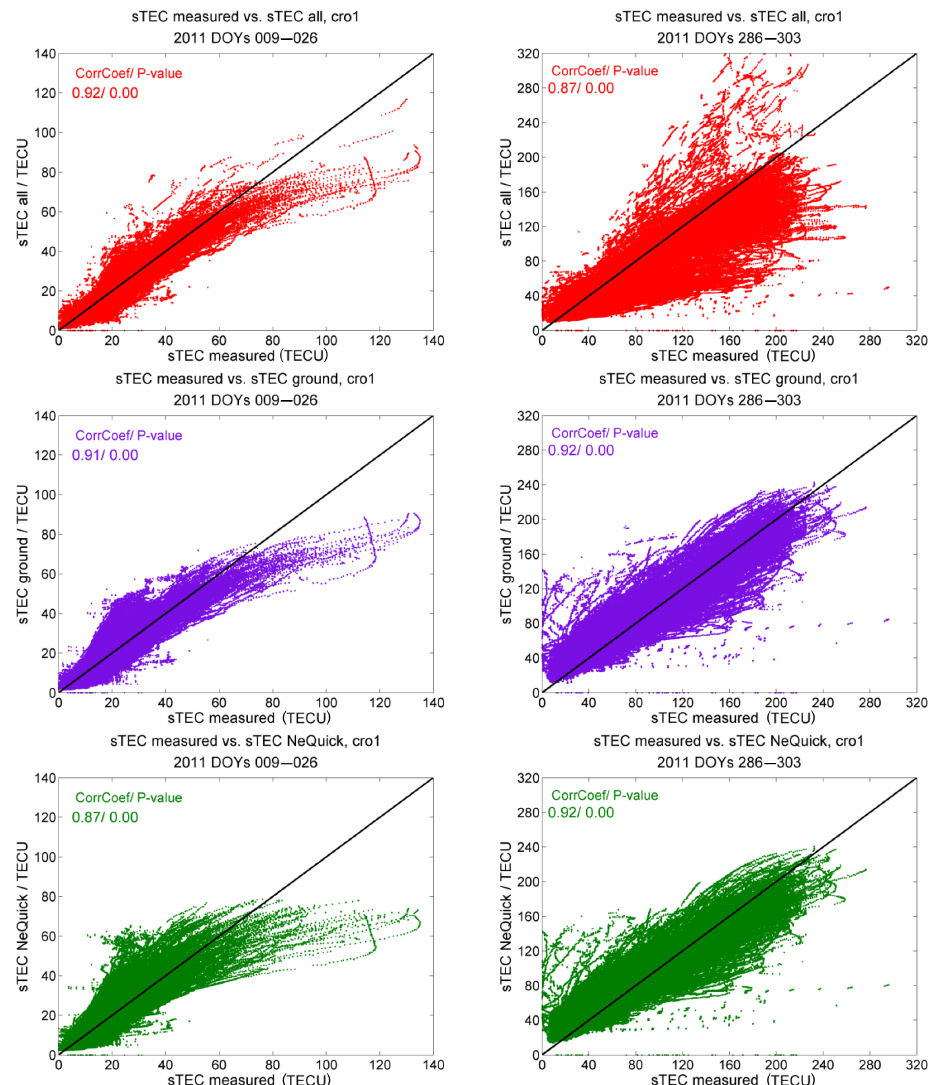
Figure 14. sTEC measured versus sTEC all (top row), sTEC ground (middle row), and sTEC model (bottom row) at the cro1 reference GNSS station in the USA during the quiet (left column) and disturbed (right column)